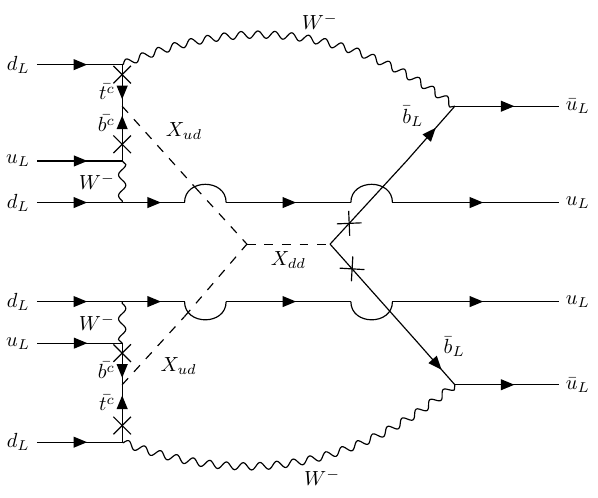
Figure 12 . A representative diagram giving rise to the dinucleon decay mode nn → π 0 π 0 at two-loop level with the scalar diquarks dominantly coupling to third generation